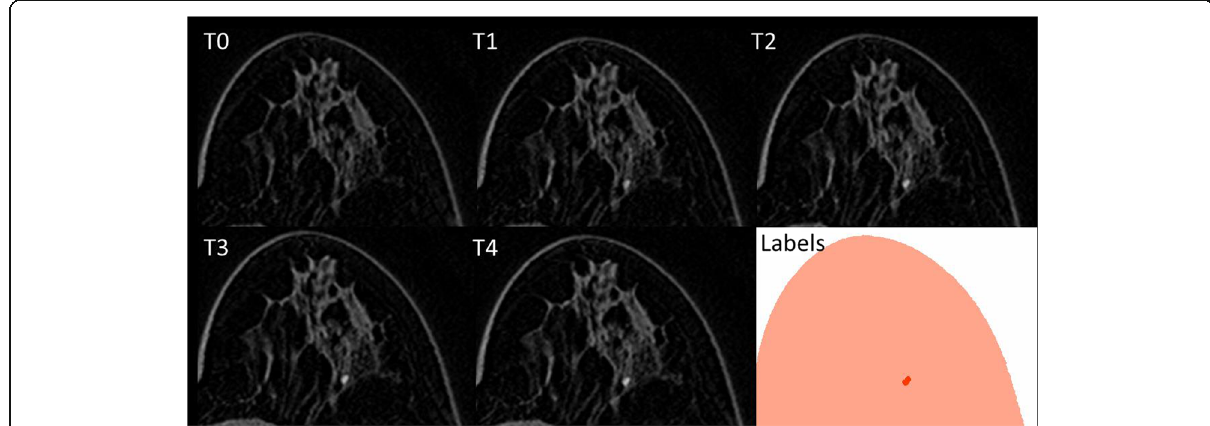
Fig. 1 Breast magnetic resonance imaging showing in T0 the first (unenhanced) image and from T1 to T4 the contrast-enhanced images, where the wash-in and wash-out phenomena give information about the malignant or benign nature of the lesion. In the last image ( “ labels ” ), the segmented focus is coloured in red while normal breast tissues are coloured in